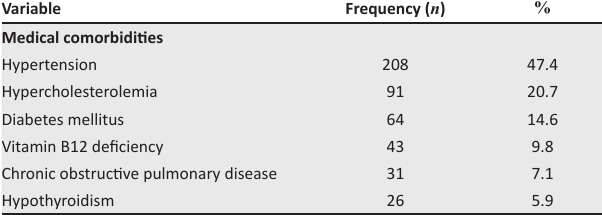
TABLE 3: Frequency of the most prevalent medical